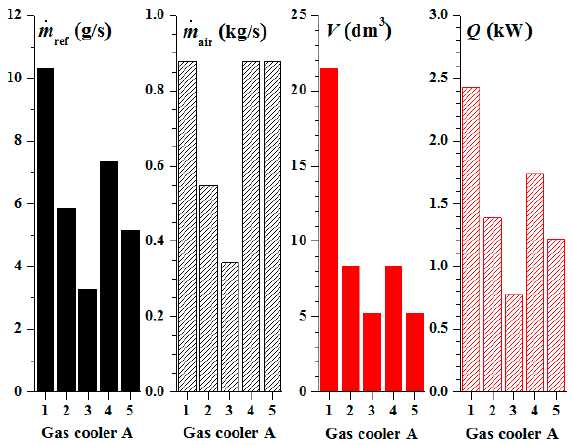
· · m ref , m air , V, and Q